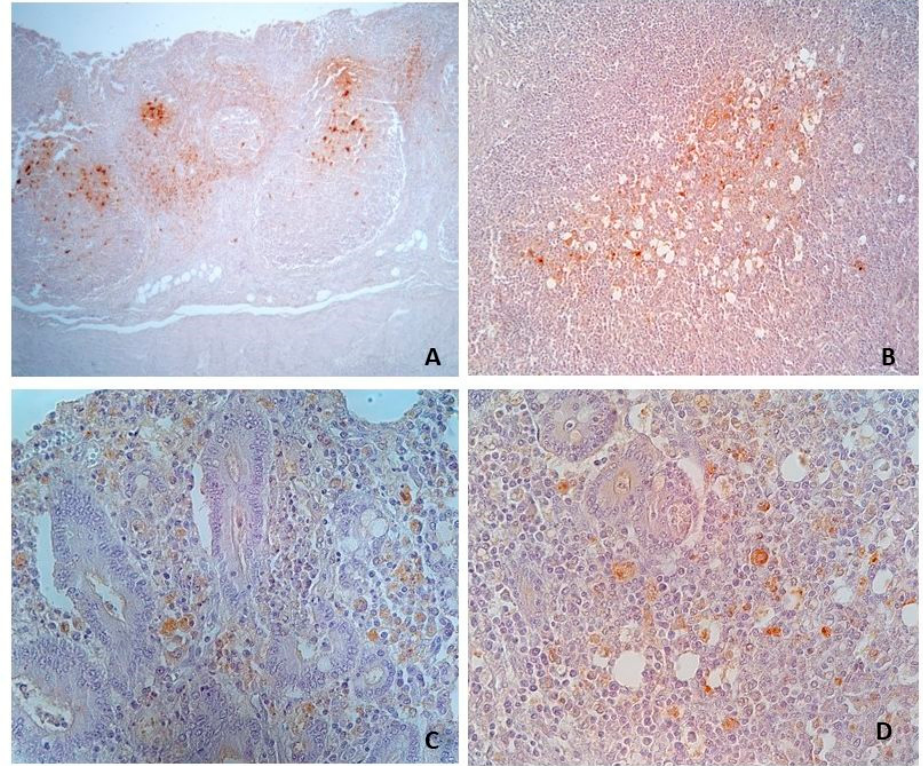
Figure 5. Swine ileum, ( A ) Case ID 1: Depletion in Peyer’s patches and immunohistochemical positive reaction to PCV2 in follicular histiocytes. ( B , C ) Case ID 6: ( B ) Positive immunohistochemical stain in the centre of a follicle of the Peyer’s patches, and ( C ) in histiocytes infiltrating the mucosa. ( D ) Case ID 7: PCV2 positive histocytes infiltrating the mucosa. ( A ): 6.3. ( B ): 16 × . ( C , D ): 40 × .